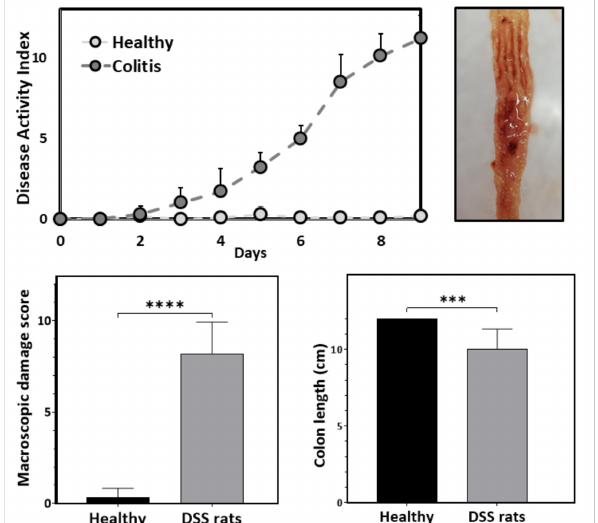
Figure 2. Disease activity index (upper left panel) in DSS-induced colitis rats; macroscopic presenta- tion of the colonic luminal surface of DSS-rats (upper right panel); macroscopic damage score (lower left panel) and colon length (lower right panel) in DSS-induced colitis rats vs. healthy animals. Data are presented as mean ± SD, n = 10, *** p ≤ 0.001, **** p ≤ 0.001. DSS, dextran sulfate sodium.